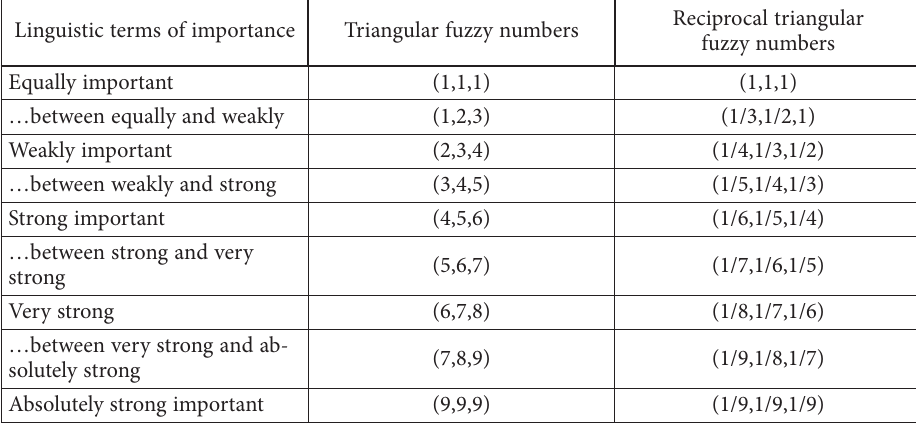
Table 2. Linguistic scale for FAHP